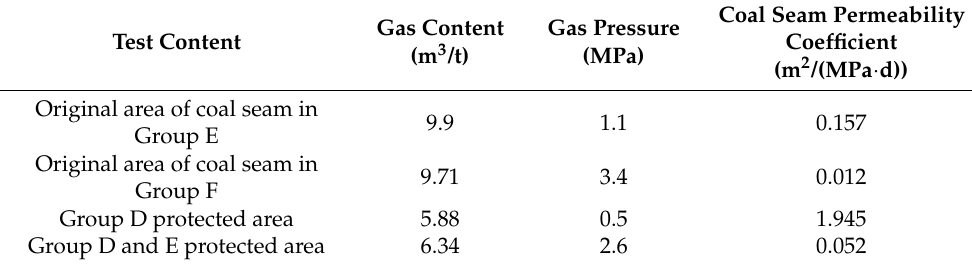
Table 3. Investigation results of gas